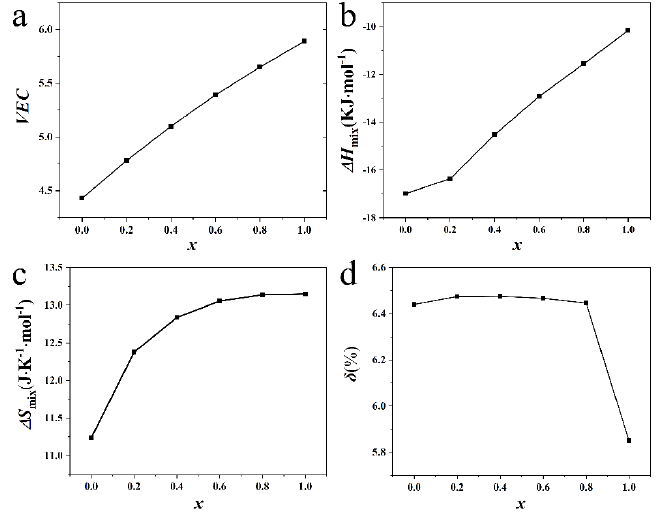
Figure 1. Variation in ( a )VEC; ( b ) mixing enthalpy Δ H mix ; ( c ) mixing entropy Δ S mix ; ( d ) atomic size difference δ versus Cu content x ( x = 0, 0.2, 0.4, 0.6, 0.8, 1) calculated for the AlCrTiV 0.5 Cu x lightweight HEAs.